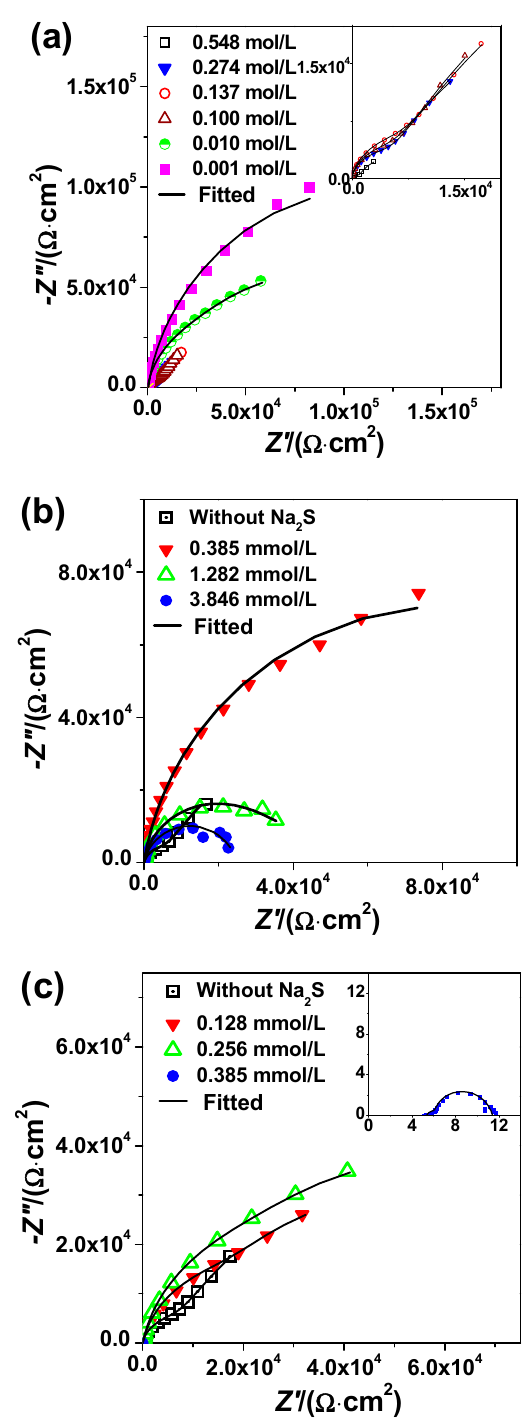
Figure 2. Nyquist plots and the fitting curves for 2205 DSS in ( a ) HCl solutions, ( b ) 0.1 mol/L HCl + Na 2 S solutions and ( c ) 0.137 mol/L HCl + Na 2 S solutions at 90 °C.